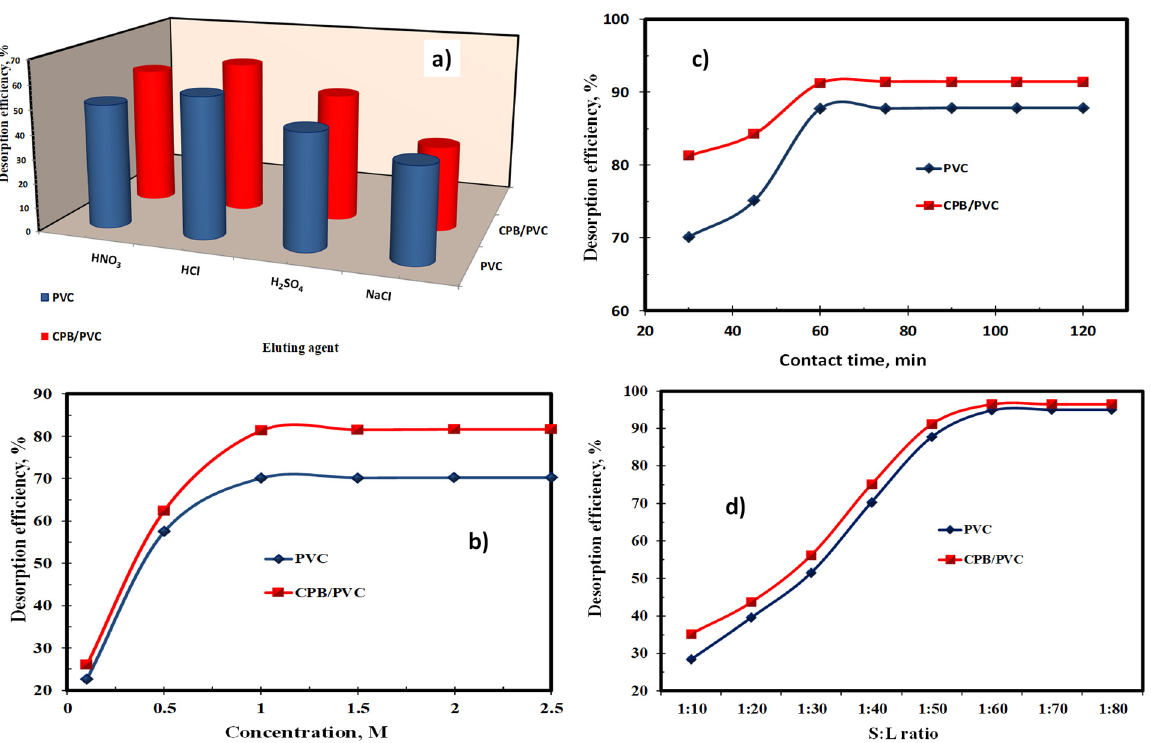
Figure 10. Effect of ( a ) eluting agents, ( b ) HCl concentration, ( c ) desorption time, and ( d ) S:L ratio upon REE desorption efficiency for the PVC and CBP/PVC sorbents.